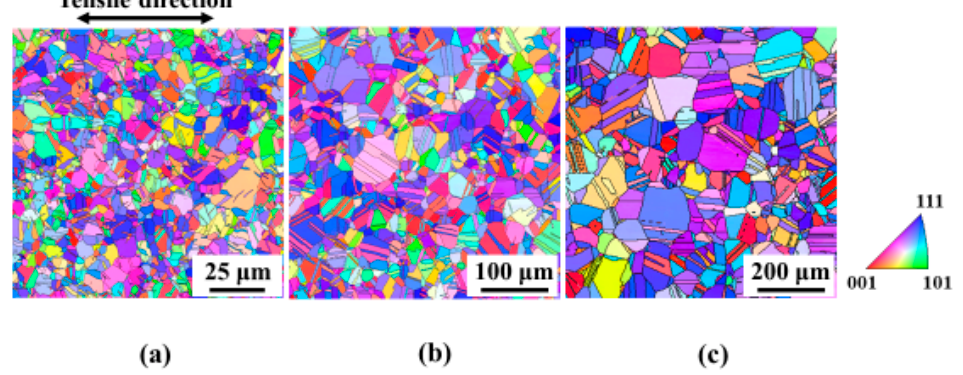
Figure 9. IPF maps for ( a ) Cu-30Zn_5, ( b ) Cu-30Zn_20, and ( c ) Cu-30Zn_60 specimens before tensile deformation. Quantum Beam Sci. 2020 , 4 , x FOR PEER REVIEW